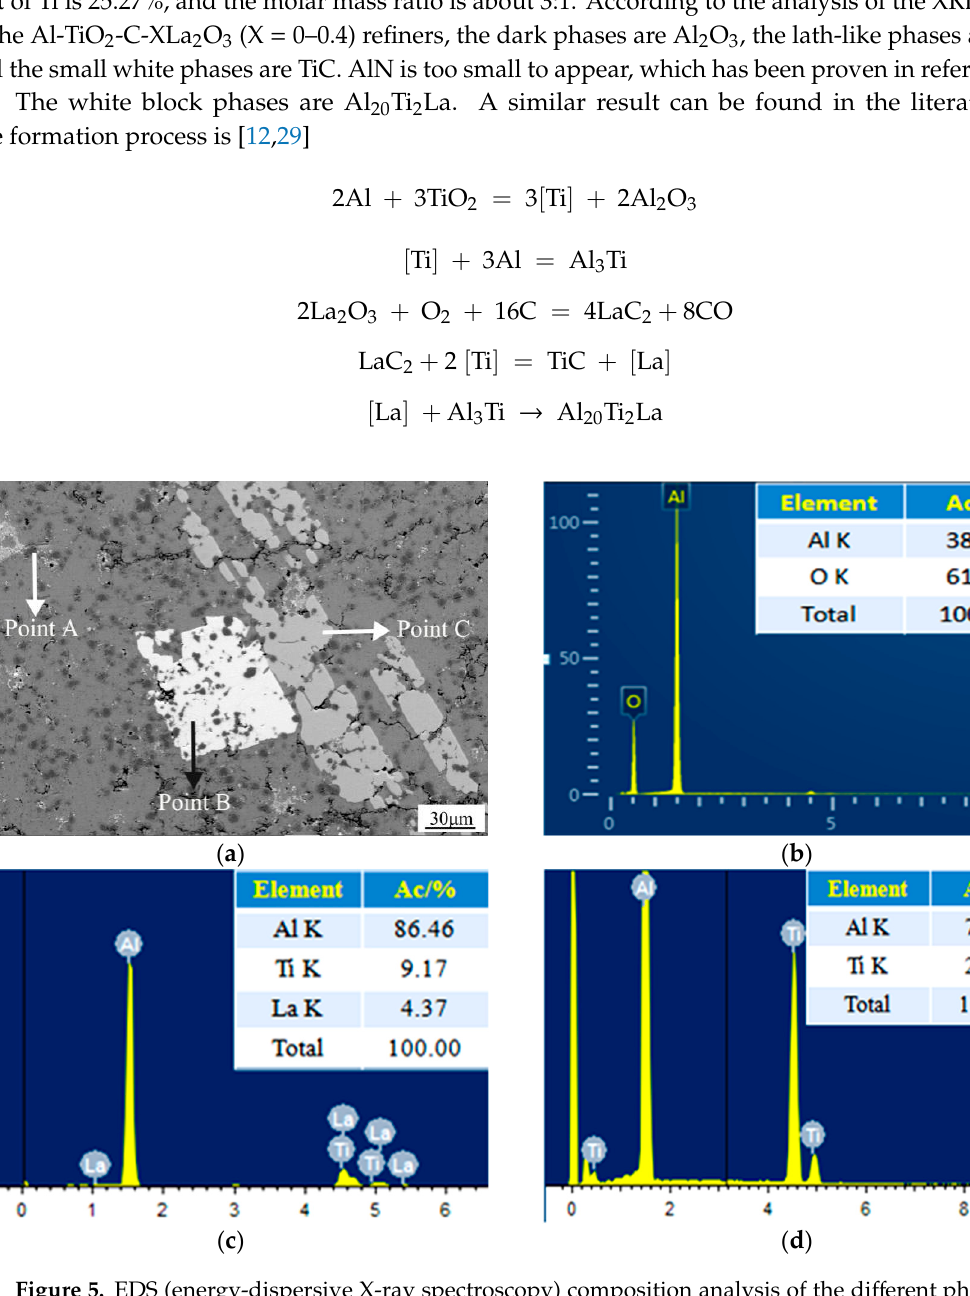
Figure 5. EDS (energy-dispersive X-ray spectroscopy) composition analysis of the different phases: ( a ) SEM ( scanning electron microscopy ) image; ( b ) Point A; ( c ) Point B; ( d ) Point C.